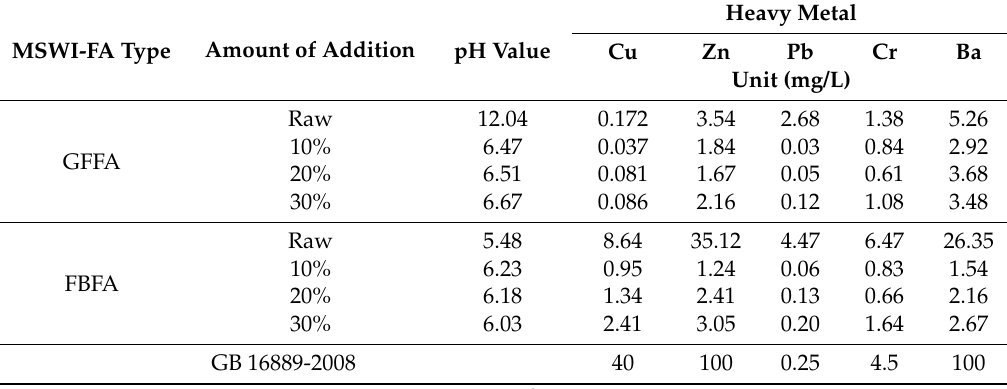
Table 6. The results of the leaching test using analytical method HJ/T